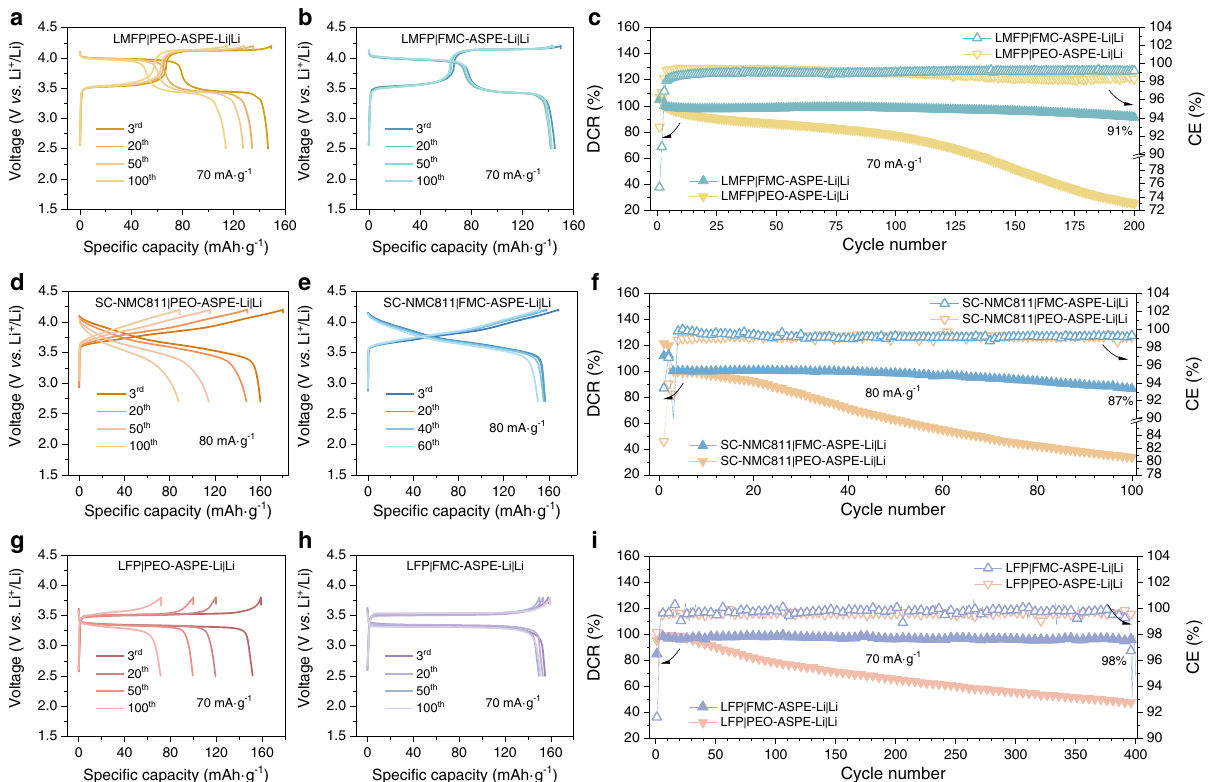
Fig. 6 Li-ion storage performance of the all-solid-state lithium metal batteries with different cathodes and all-solid-state polymer electrolytes (CR2032 coin cell, 70 °C). a , b Comparison of the charge/discharge voltage pro fi les of a LMFP|PEO-ASPE-Li|Li and b LMFP|FMC-ASPE-Li|Li full cells. c Comparison of discharge capacity retention (DCR) and coulombic ef fi ciency (CE) of LiMn 0.6 Fe 0.4 PO 4 (LMFP)|PEO-ASPE-Li|Li and LMFP|FMC-ASPE-Li|Li full cells; d , e Comparison of the charge/discharge voltage pro fi les of d single-crystal LiNi 0.8 Mn 0.1 Co 0.1 O 2 (SC-NMC811)|PEO-ASPE-Li|Li and e SC-NMC811| FMC-ASPE-Li|Li full cells. f Comparison of DCR and CE of SC-NMC811|PEO-ASPE-Li|Li and SC-NMC811|FMC-ASPE-Li|Li full cells. g , h Comparison of the charge/discharge voltage pro fi les of g LiFePO 4 (LFP)|PEO-ASPE-Li|Li and h LFP|FMC-ASPE-Li|Li full cells. i Comparison of DCR and CE of LFP|PEO-ASPE-Li| Li and LFP|FMC-ASPE-Li|Li full cells. The mass of the positive electrode active material was used for calculating the speci fi c capacity and speci fi c (SEM, Fig. 5l, m) on the Li|FMC-ASPE-Li|Li and Li|PEO-ASPE- Li|Li symmetrical cells stopped after ten plating/stripping cycles (0.1 mA cm − 2 , 0.1 mAh cm − 2 ). As shown in Fig. 5j, severe Li